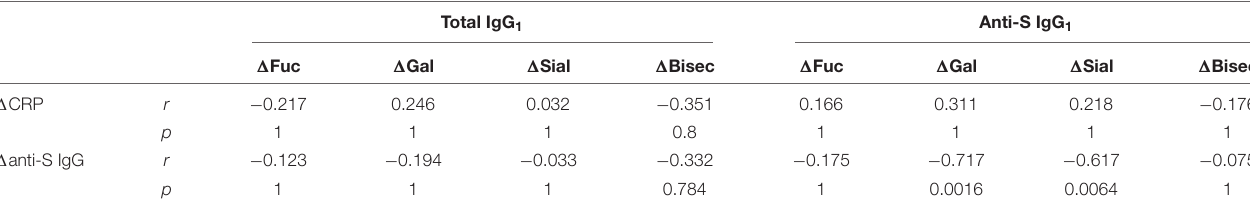
TABLE 2 | Correlation between COVID-19-related differences in total and anti-S IgG 1 -specific glycosylation traits and the difference in CRP and anti-S IgG plasma concentration in COVID-19